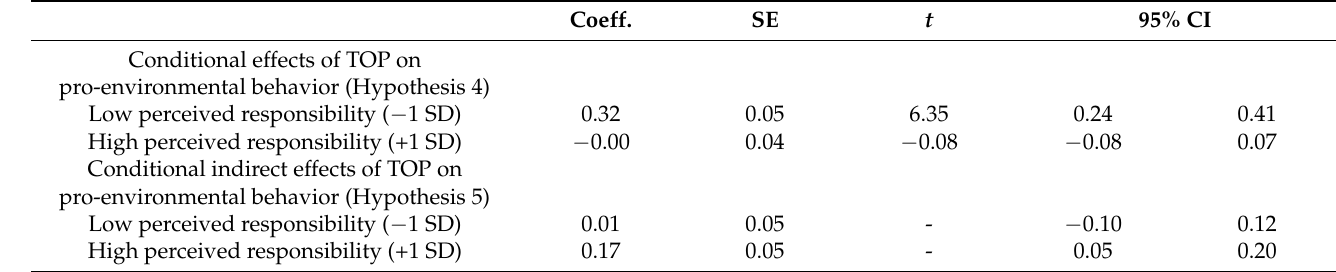
Table 5. Results for Hypothesis